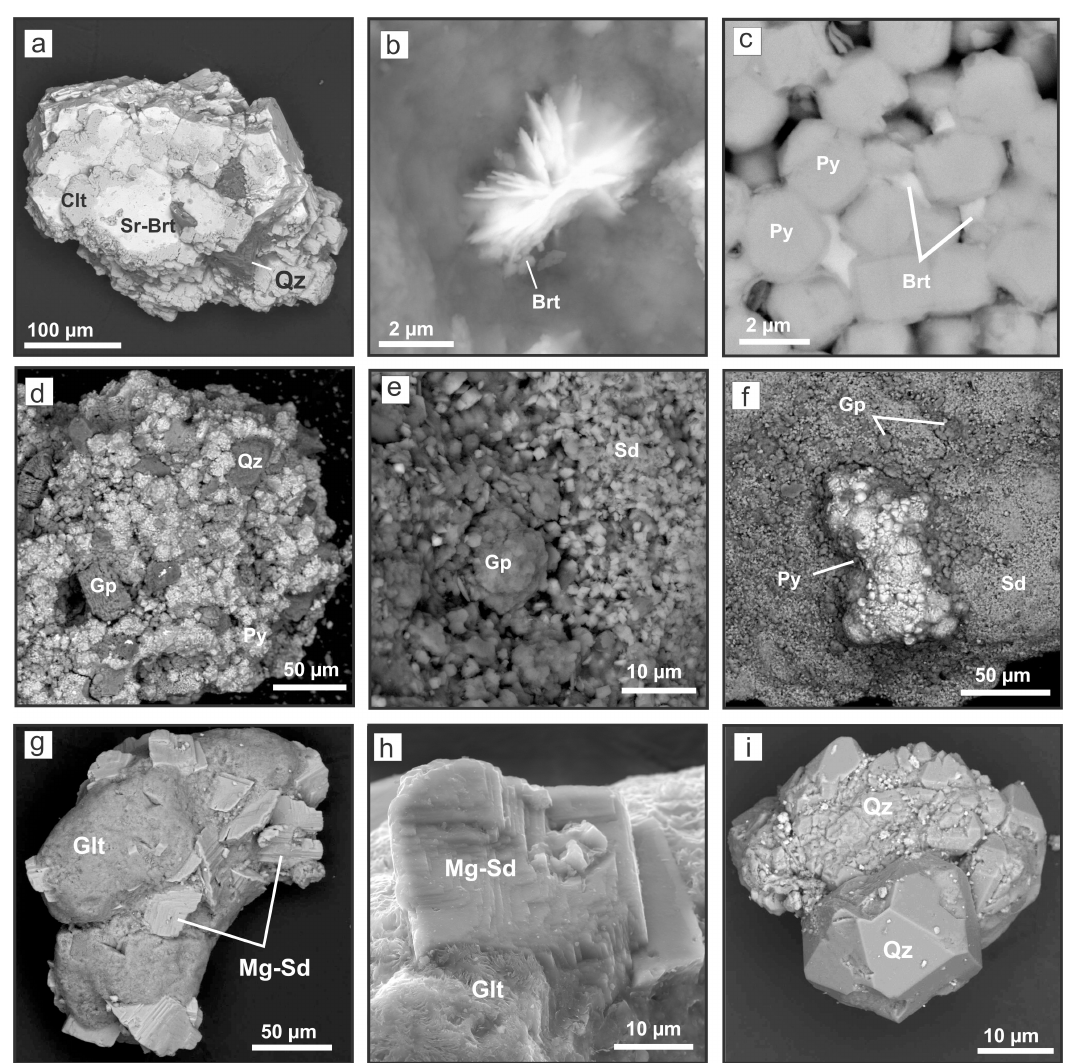
Figure 9. Morphology of sulphates, glauconite and quartz from mud masses (Bulganak area). ( a ) Intergrowth of Sr-barite, celestine and quartz. Celestine forms rims around earlier Sr-barite; ( b ) Star-like aggregate of barite; ( c ) Barite filling space between pyrite crystallites; ( d ) Prismatic gypsum crystals coexisting with recrystallised pyrite framboids and quartz; ( e , f ) Granular aggregates of unfaceted gypsum grains covering intergrowths of fine-grained siderite and recystallised pyrite; ( g , h ) Intergrowth of rhombohedral Mg-siderite and glauconite pellets. Mg-siderite crystals have rough faces. Glauconite pellets are composed of aggregate of overlapping micaceous flakes with no preferred orientation; ( i ) Quartz euhedral crystals. BSE images. Brt = barite; Sr-Brt = Sr-barite; Clt = celestine; Glt = glauconite; Gp = gypsum; Py = pyrite; Qz = quartz; Sd = siderite. ( a , b ) = Trubetskoy Hill; ( c , g , h , i ) = Andrusov Hill; ( d – f ) = Tischenko Hill.